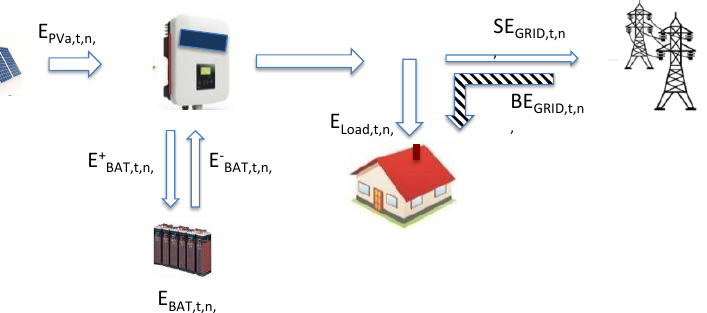
Figure 2. Energy flows in the PV system with the battery.